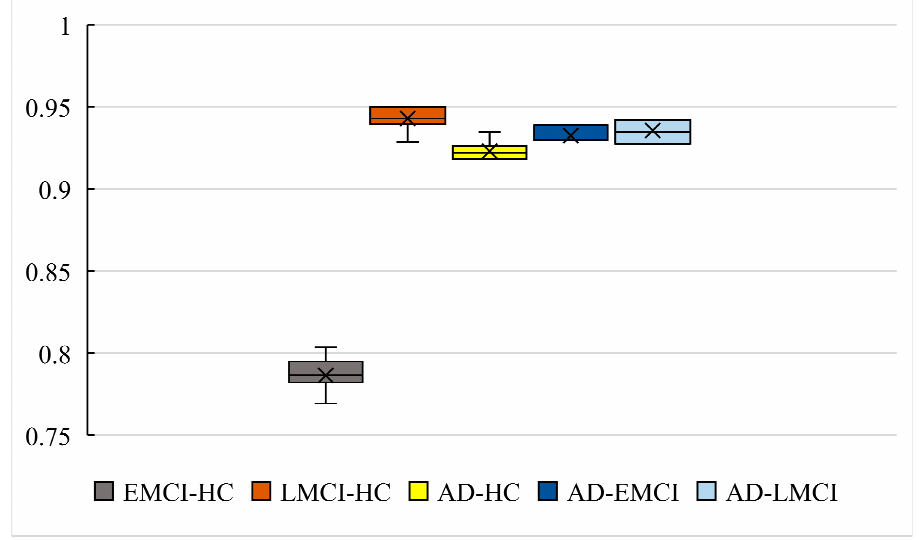
Figure 9. The classification accuracy of our models in five datasets.